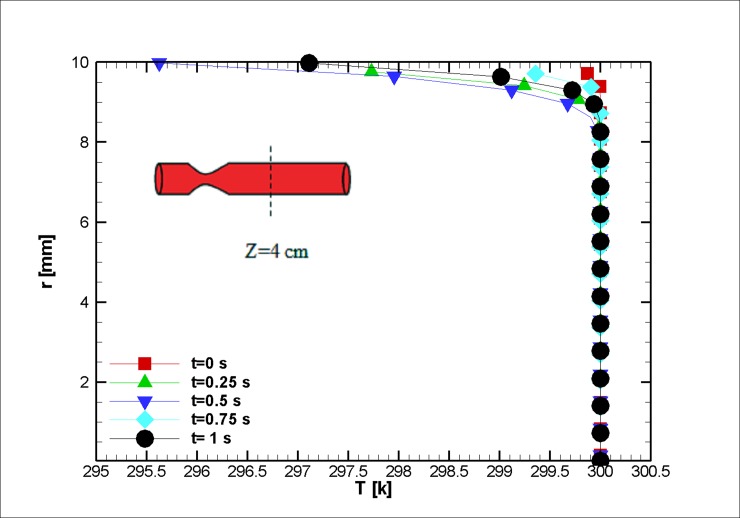
Profile of the temperature distribution at z = 4 cm for the case without Joule heating at five different time instances, Lvessel = 7 cm, Rvessel = 1 cm and fifty percent stenosis.